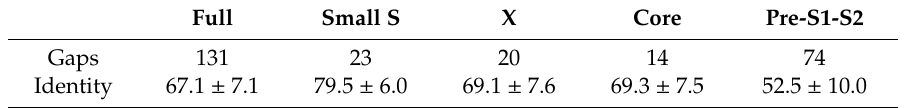
Table 1. The number of sequence gaps and sequence identities (%) in the full genome and each